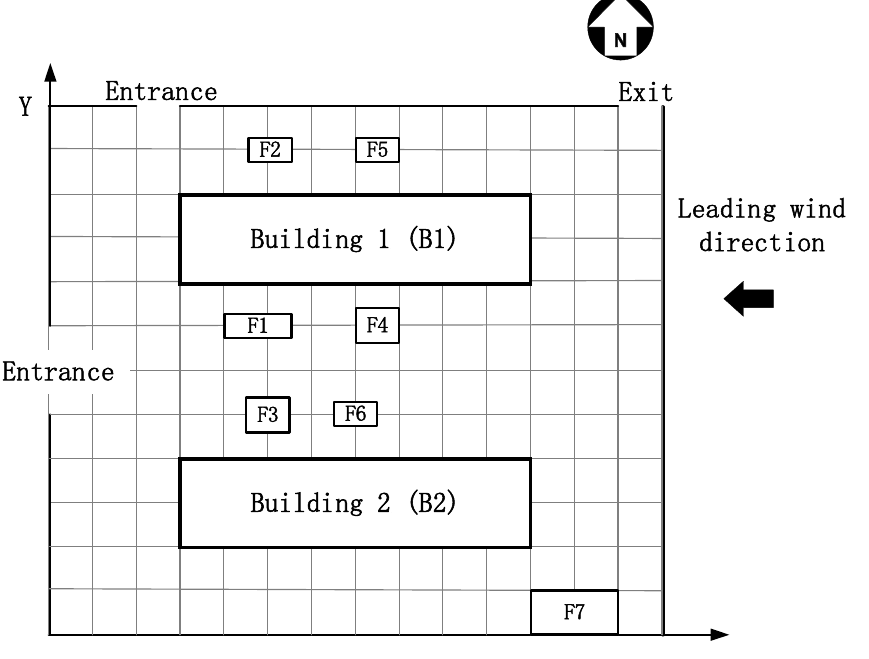
Figure 5. The optimized construction site layout plan.